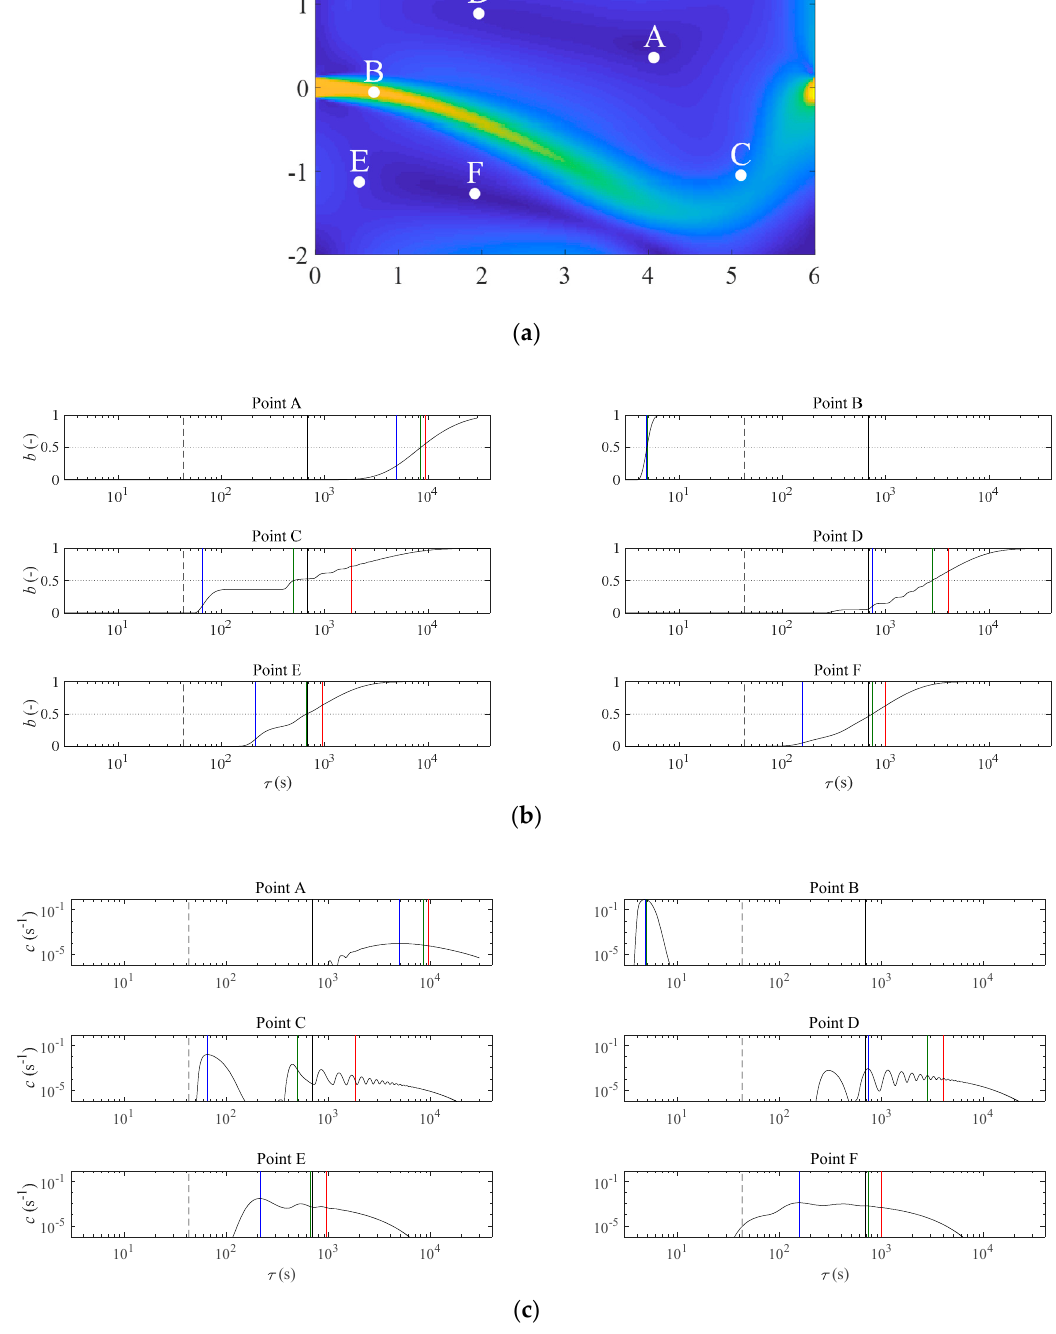
Figure 5. Water age distribution at six locations in the reservoir for Test 5: ( a ) considered locations A, B, C, D, E and F, ( b ) cumulated distributions b and ( c ) water age distributions c . The blue ( − ), green ( − ) and red ( − ) vertical lines show the mode, median and mean of the age distribution, respectively. The plain ( − ) and dashed ( -- ) black vertical lines represent the characteristic times V / Q and L /( Q / S in ), respectively.